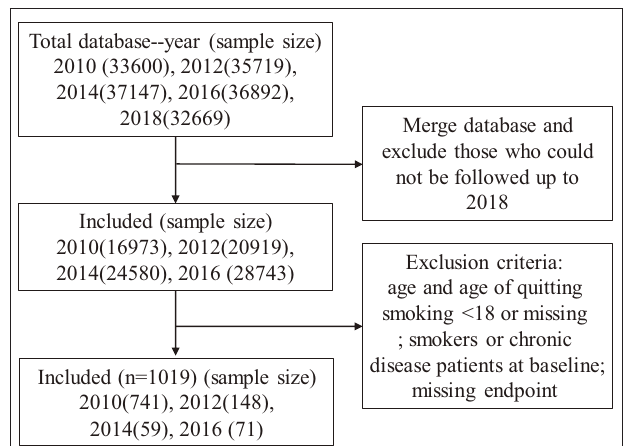
FIGURE 1 | Sample screening flowchart. The study used a 2010-2018 CFPS database with exclusion criteria: 1. Participants who were in the cohort from 2010 to 2016 but could not be followed up to 2018; 2. Participants whose age and age of quitting smoking were less than 18 or missing; 3. Smokers and patients with chronic diseases in baseline years; 4. Participants with missing endpoint events. A total of 1019 participants were included.